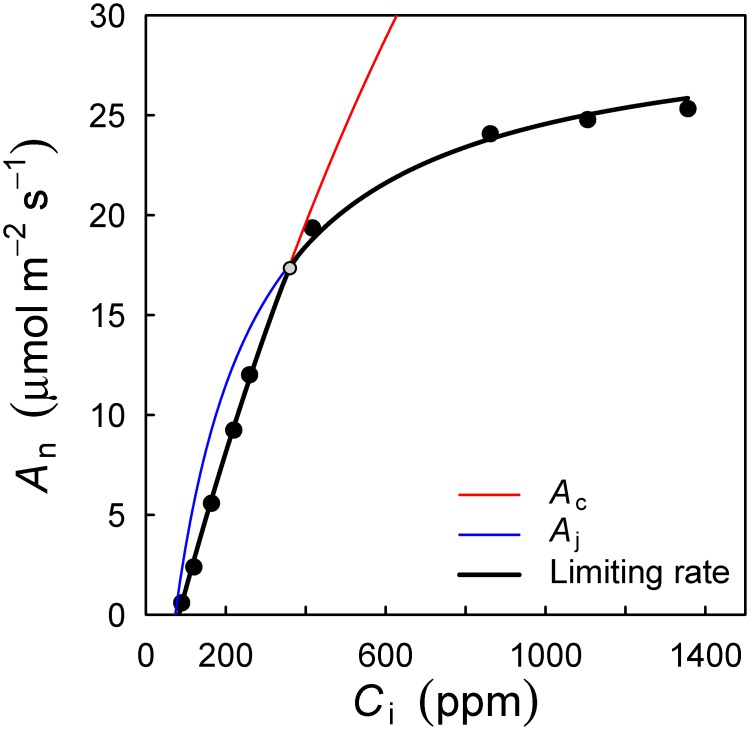
Standard output from the fitaci function.An is the net photosynthetic rate, Ci the intercellular CO2 concentration. Symbols are measurements, the black line the fitted FvCB model of photosynthesis. Colored lines indicate the two photosynthesis rates in the FvCB model. In the default mode, the fitaci function estimates Vcmax, Jmax and Rd from the fitted curve. Optionally, Rd is provided as an input, for example when it was measured separately. In this example, Vcmax was estimated as 46.8 (SE 1.47), Jmax was 105.2 (SE 1.36) and Rd was 1.3 (SE 0.24). Assumed parameters were Km = 1460 and Γ* = 64.8 (all in units of μmol m-2 s-1). The R2 of a regression of measured vs. fitted was 0.99.